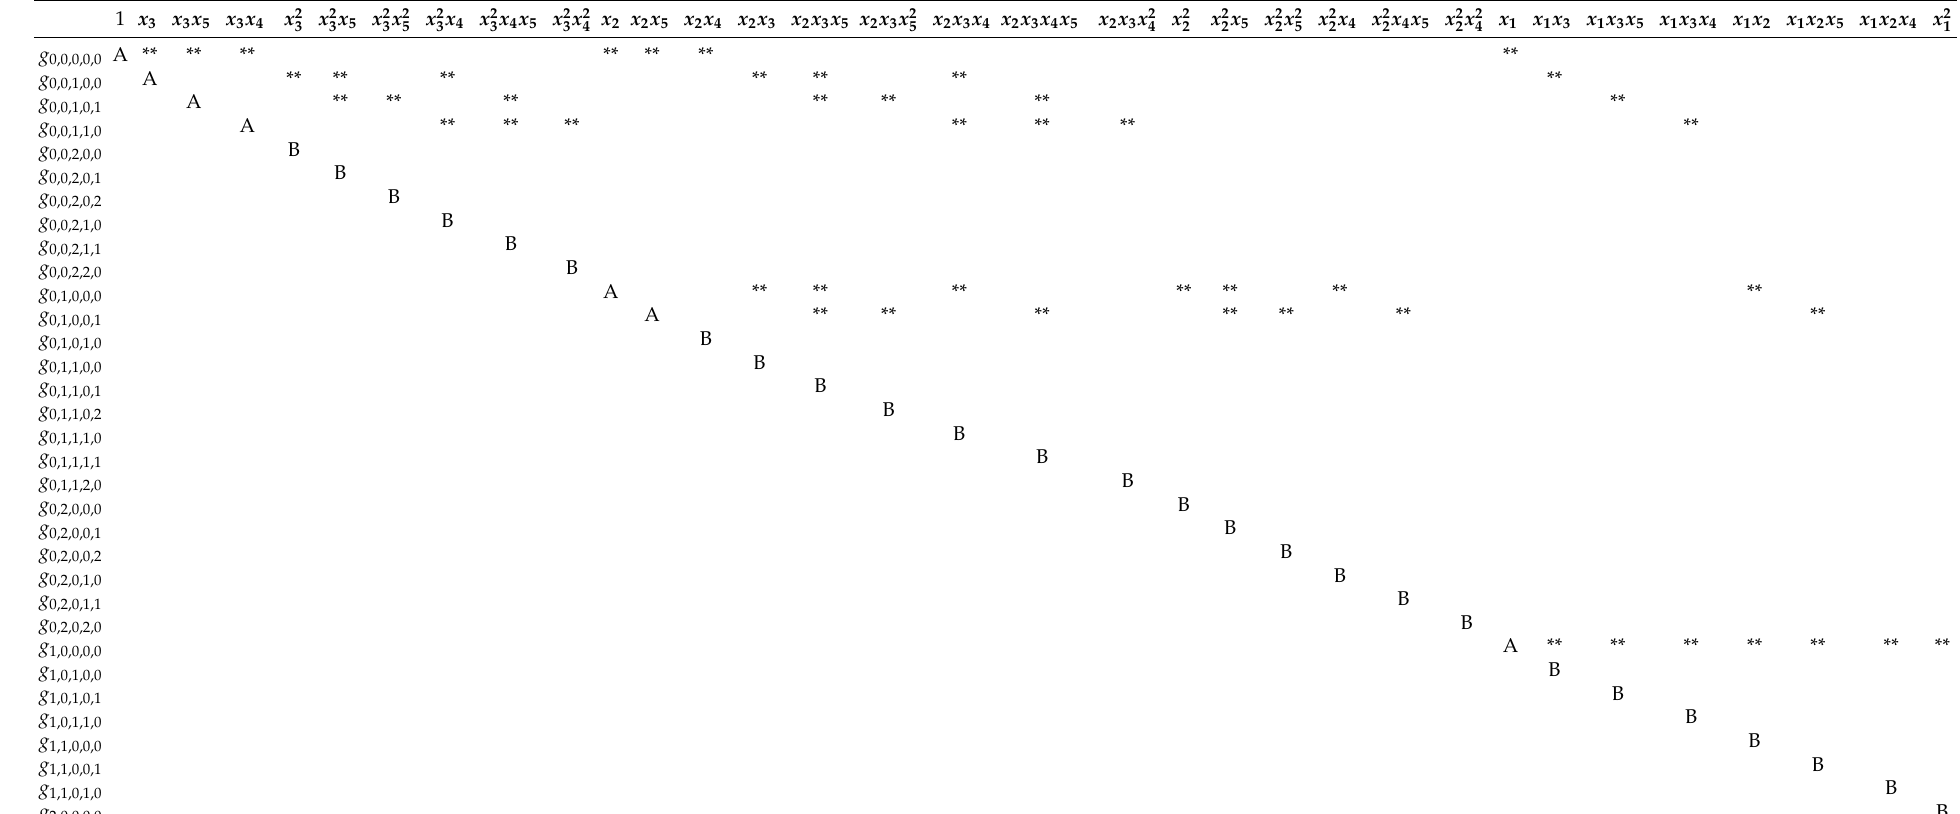
Table A1. The coefficient matrix for the case m = 2 and t =